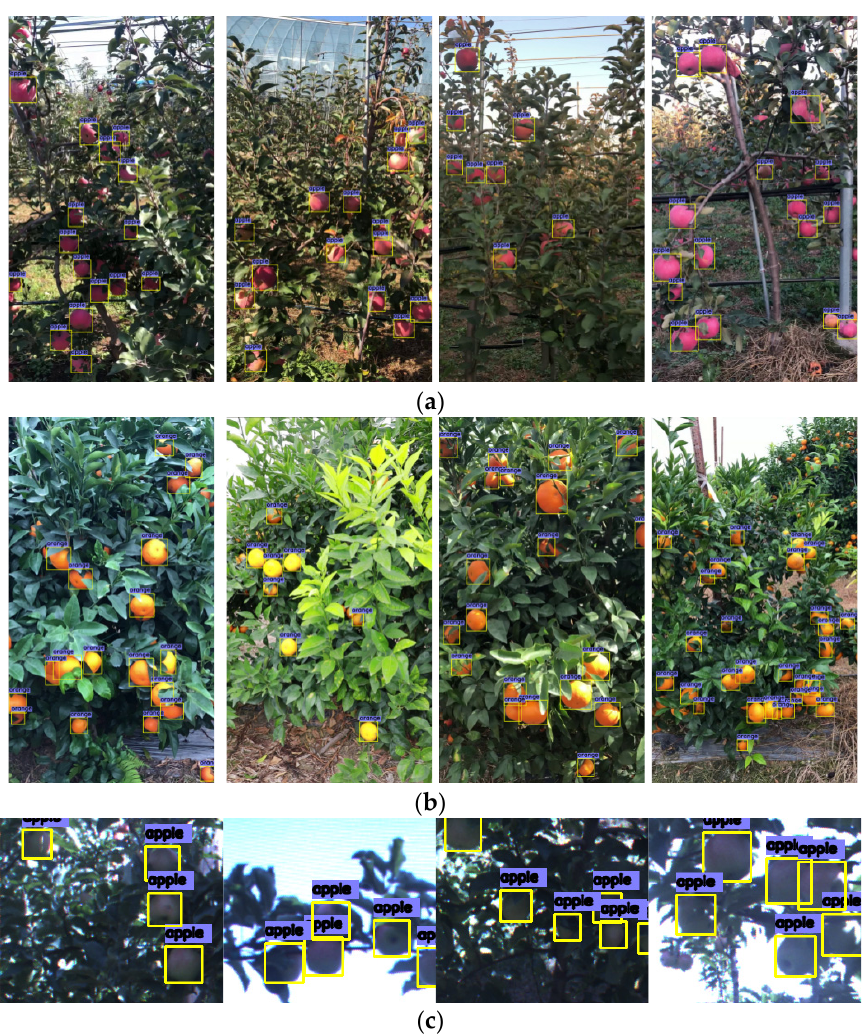
Figure 9. Illustration of the fruit detection results. ( a ) Illustration of the apple detection result in the collected dataset of this study, ( b ) Illustration of the orange detection result in the collected dataset of this study, ( c ) Illustration of the apple detection result in the ACFR-Apple dataset.